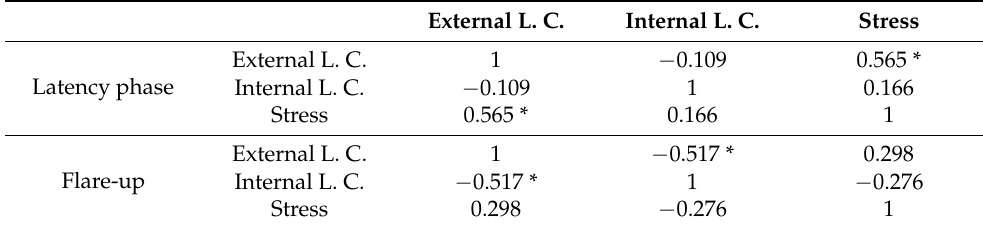
* Correlation is significant at level 0.01